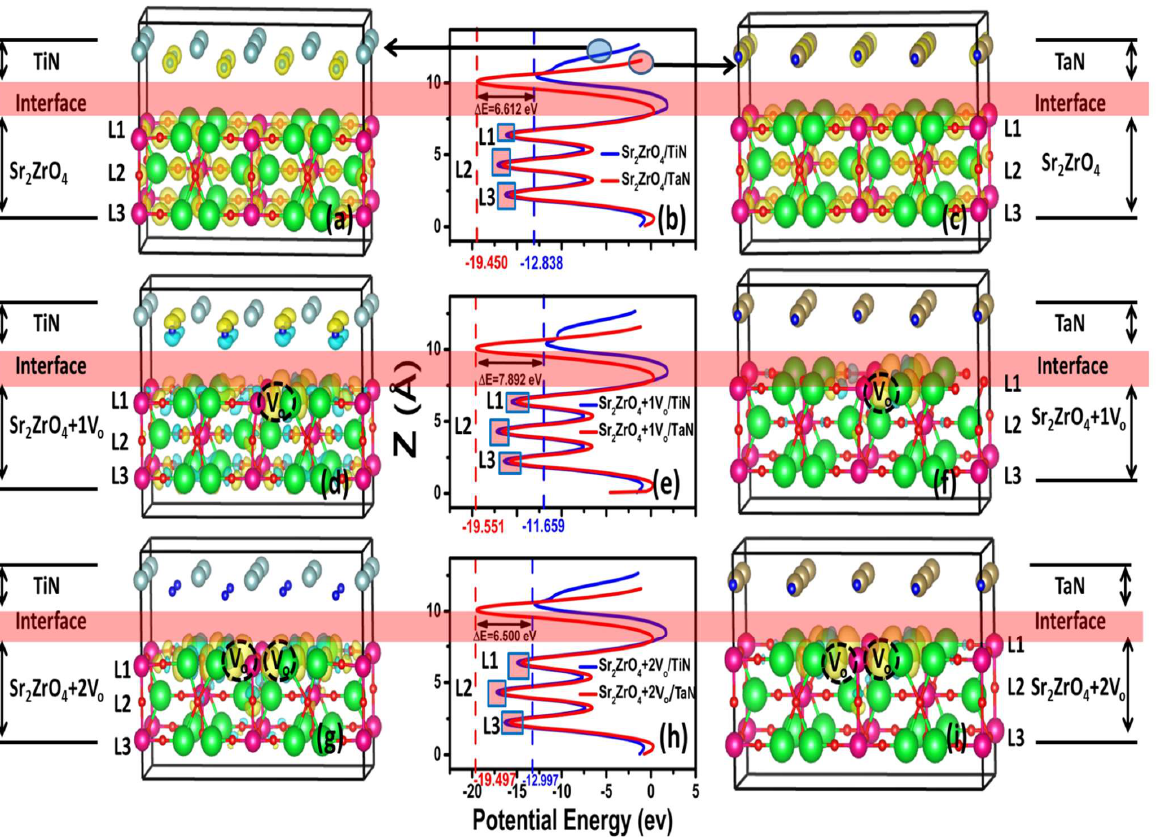
Figure 5. Potential energy lineups in middle panel and their respective isosurface charge density plot in left and right panel for ( a – c ) pristine ( d – f ) pristine + 1V o ( g – i ) pristine + 2V o 2D layered RP perovskite structures.